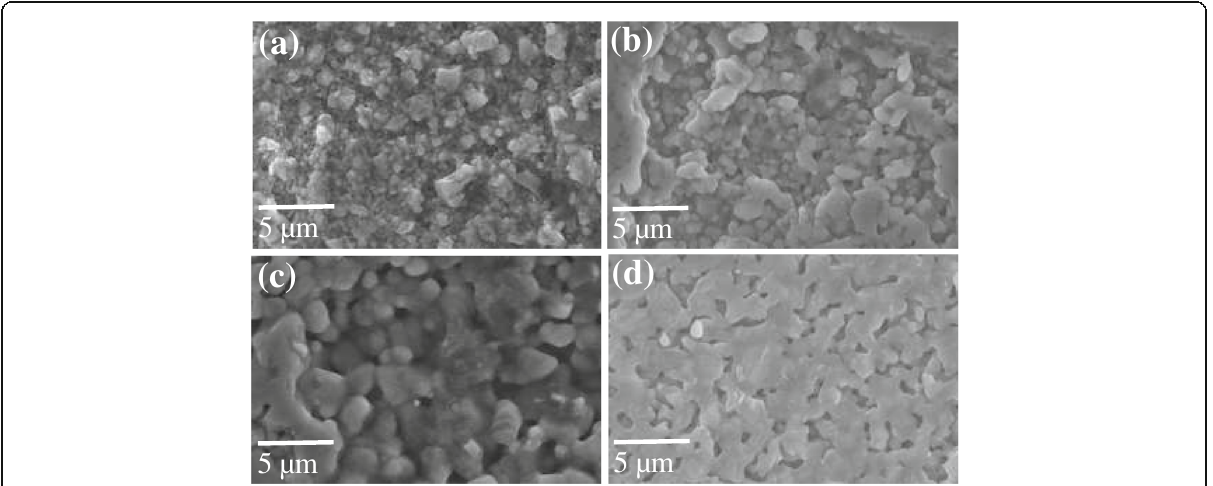
Fig. 5 FESEM images of the sintered SiC with nano-sized Si-SiC composite particles by SPS process at a 1600 °C, b 1700 °C, c 1800 °C sintering